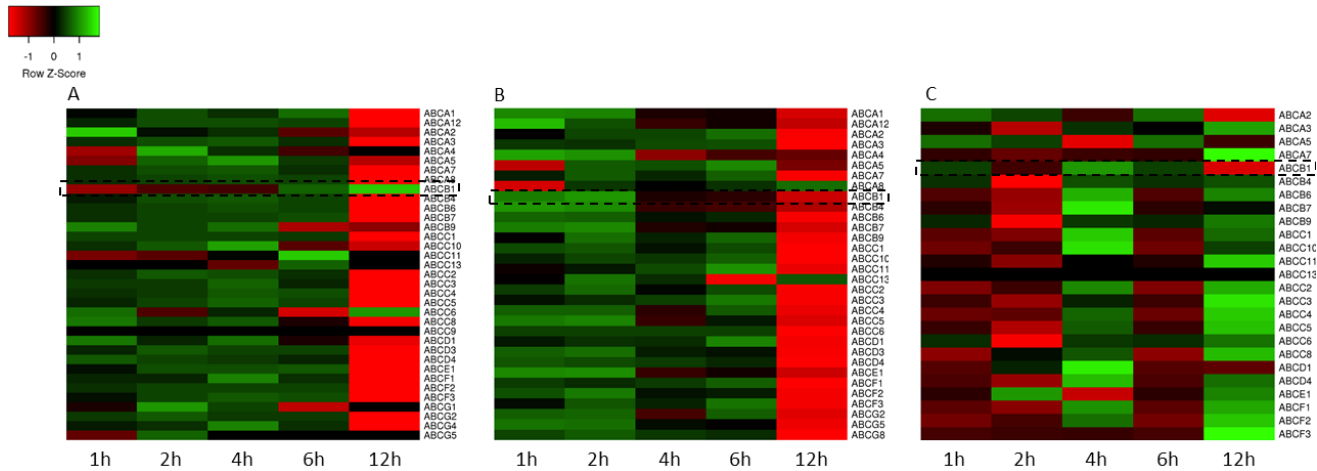
Figure 2. Heatmaps representing the expression profile of the genes encoding ABC transporters in A549 ( A ), HepG2 ( B ) and SW620 ( C ) cell lines treated for 1, 2, 4, 6 and 12 h with 50 μg/cm 3 Ag20. Rows represent genes and columns represent incubation time. The intensity of each color represents the standardized ratio between each value and the average expression of each gene in all samples. Data expressed as the arithmetic mean of relative gene expression normalized to untreated cells; n = 3.